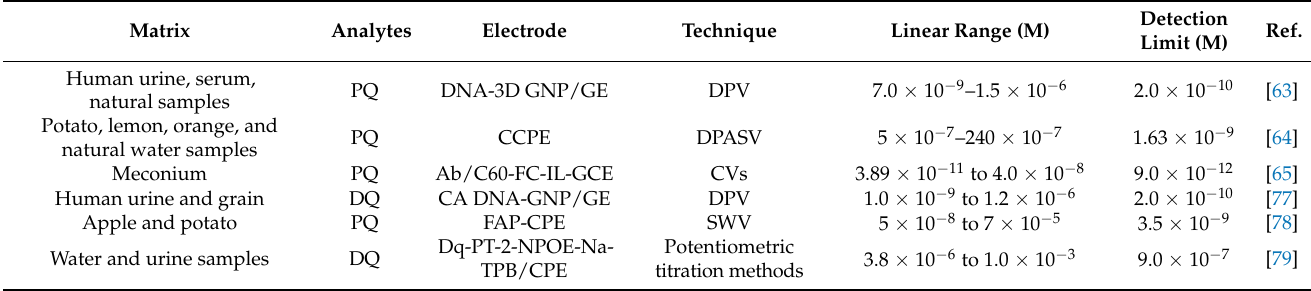
Table 4. Examples of electrochemical sensors for the detection of PQ and